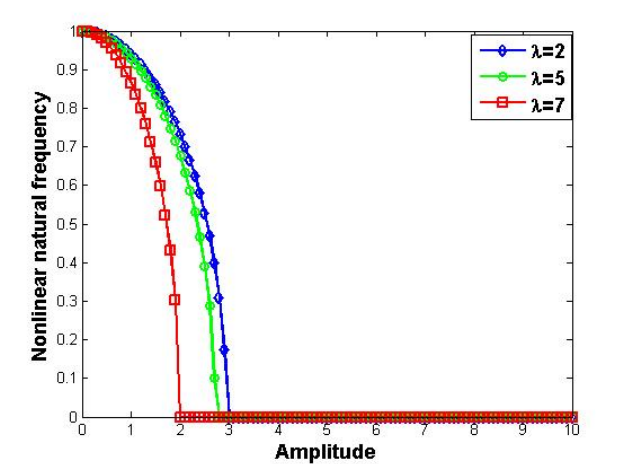
Figure 11. Influence of Aspect ratio variation on nonlinear natural